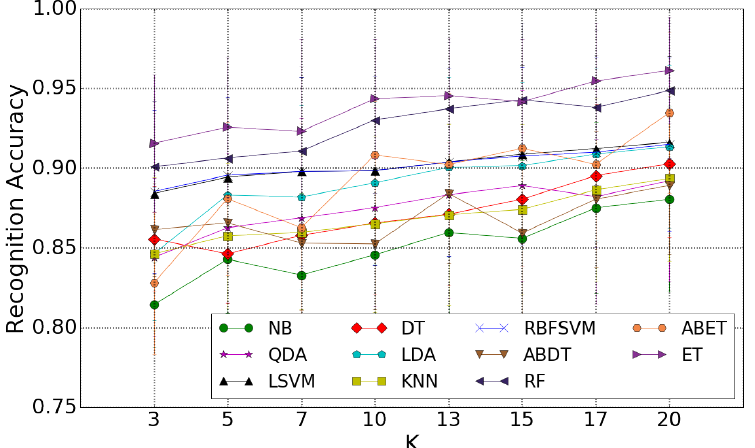
Figure 3. K -fold cross validation results for all machine learning approach and for several values of K